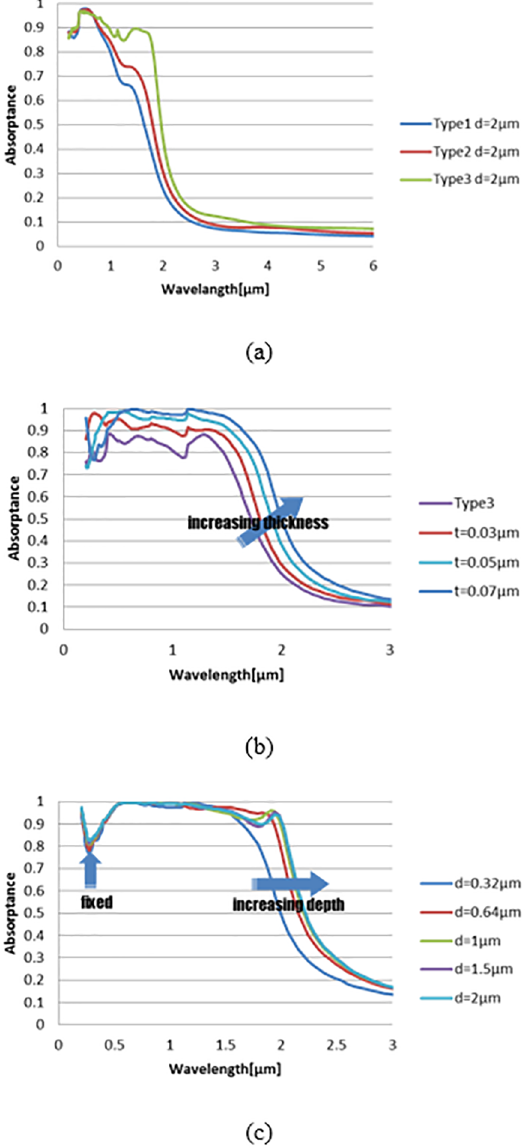
Figure 7. Absorptance spectrum of (a) different PhC types (b) type 3 PhC with different ARC thickness coatings (c) type 3 PhC with different structure depths and ARC coating of 0.07µm.